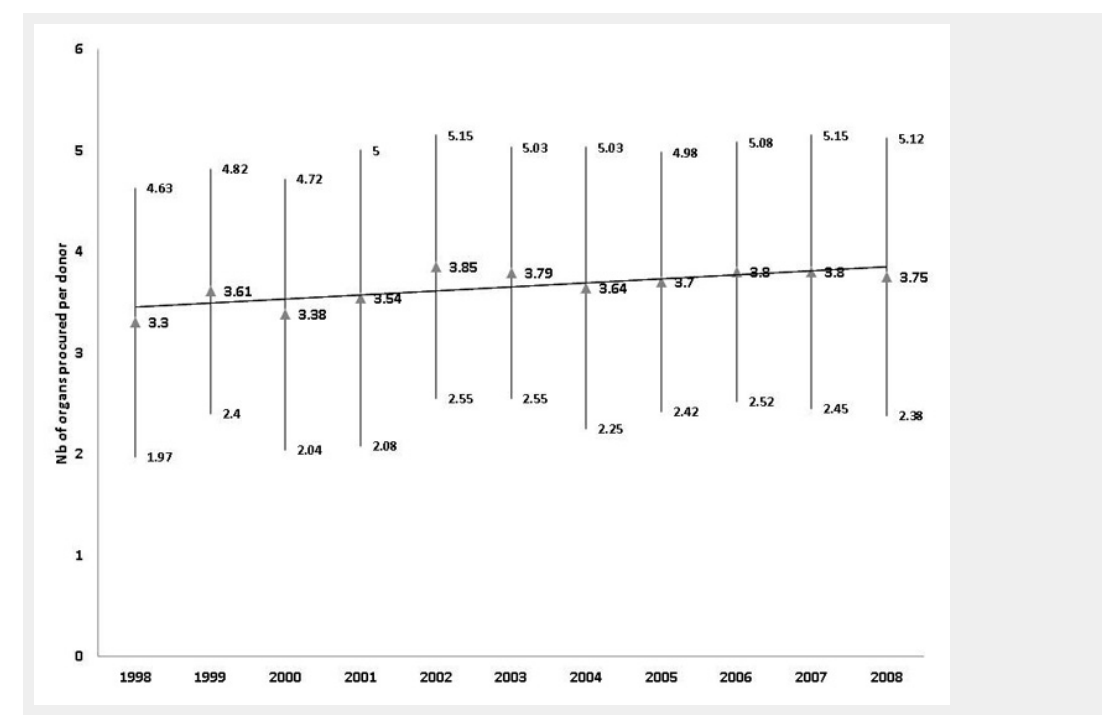
Figure 3 Average number of organs procured per donor, displaying ±1.SD (standard deviation) and linear trend.